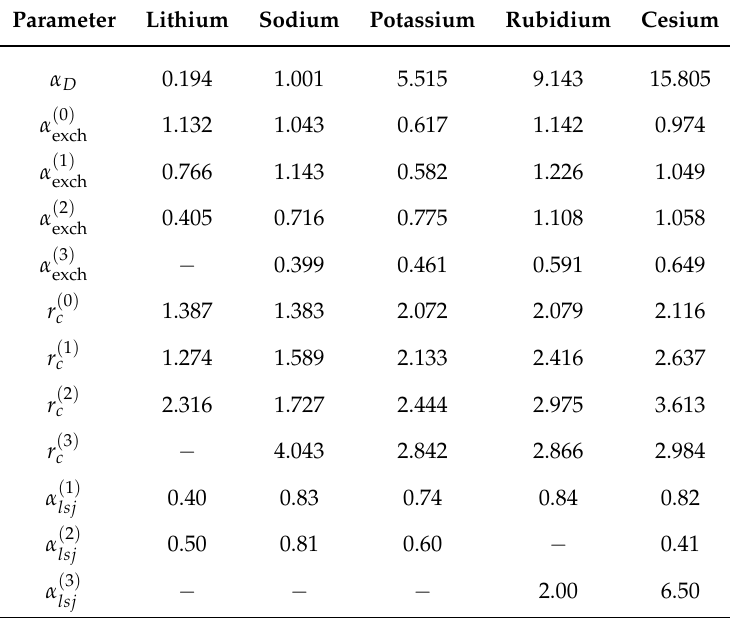
Table 1. Local central model potential parameters for alkali atoms. The ‘ − ’ indicates that this part of the potential is found to be insignificant. The static dipole polarizability of the ionic cores is from [29]. Parameter